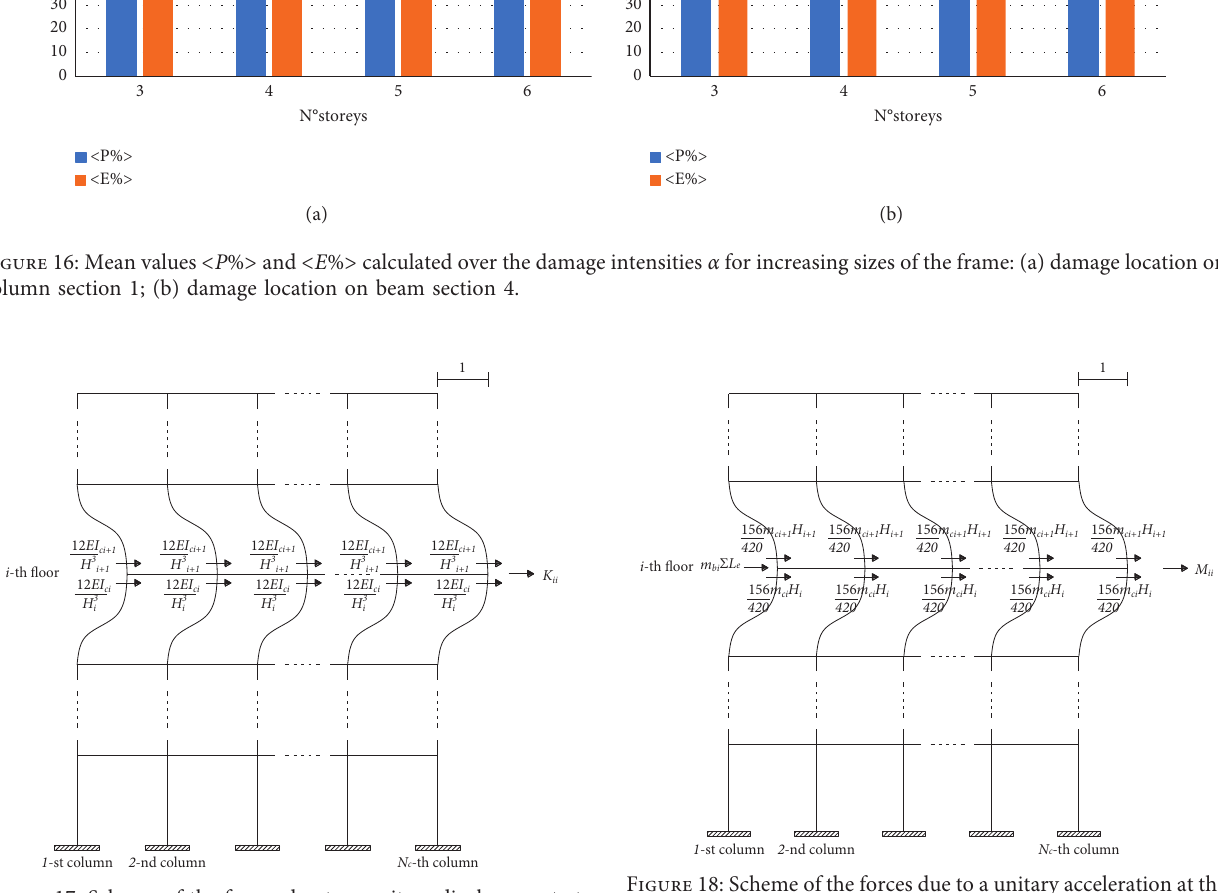
Figure 17: Scheme of the forces due to a unitary displacement at the ( i )-th floor for computing the K ii term of the stiffness matrix.